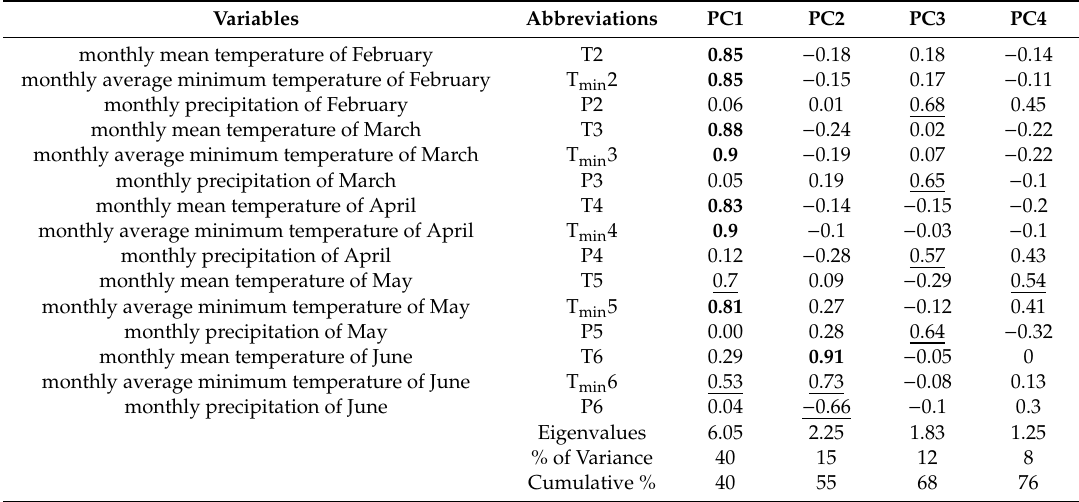
Table 2. Loadings of variables (15) on principal components (PCs) for Zone I spring